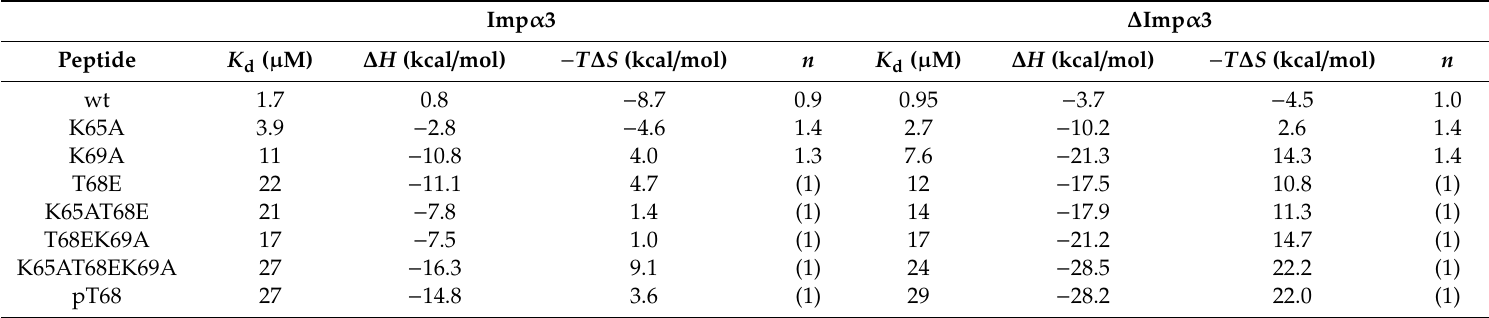
Table 2. Thermodynamic parameters at 298 K in the binding reaction of NLS NUPR1 peptides to the two importin species a